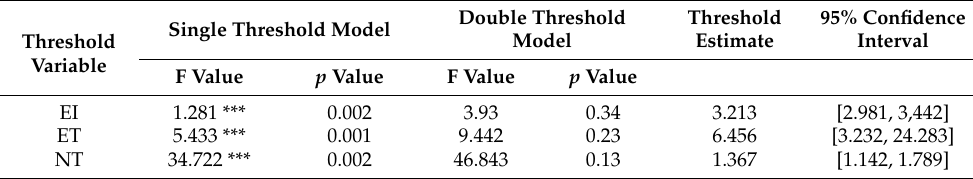
Table 5. Threshold effect test